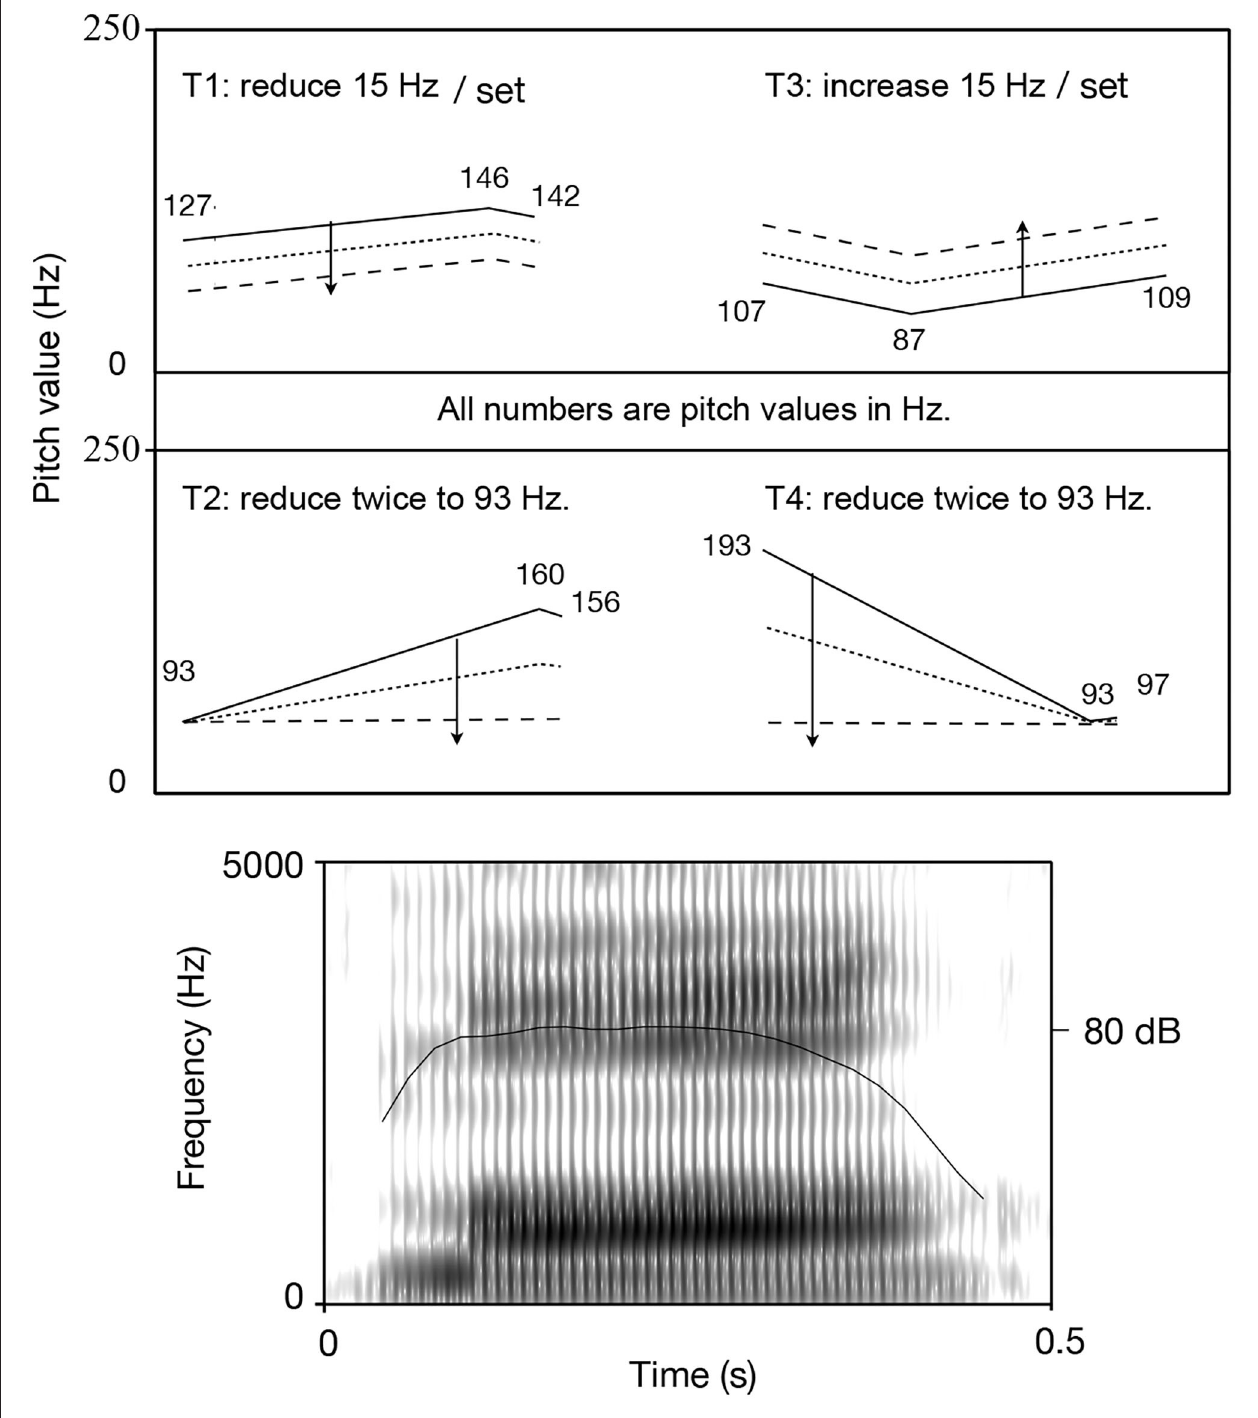
FIGURE 1 | Generation of stimuli: manipulated tonal contours (set 1: solid line, set 2: dashed line, set 3: dotted line; the arrow shows the manipulating direction; pitch value is marked out for the original curve) (upper), and the spectrogram of the Putonghua syllable /ma/ for generation of stimuli (lower).